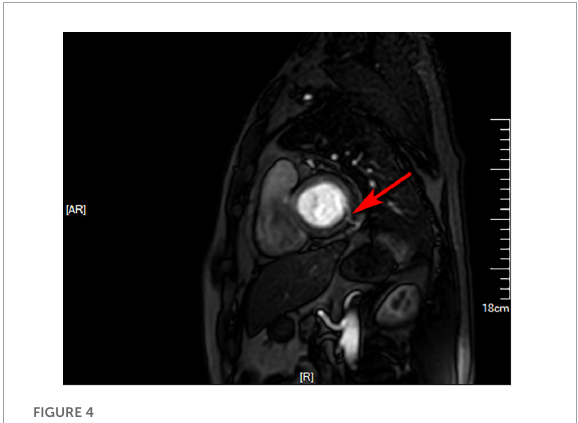
FIGURE4 Cardiovascular magnetic resonance. Suspicious fistula at the base of the inferior lateral wall (red arrow) was seen from the left ventricular short axis at 4 o’clock direction.